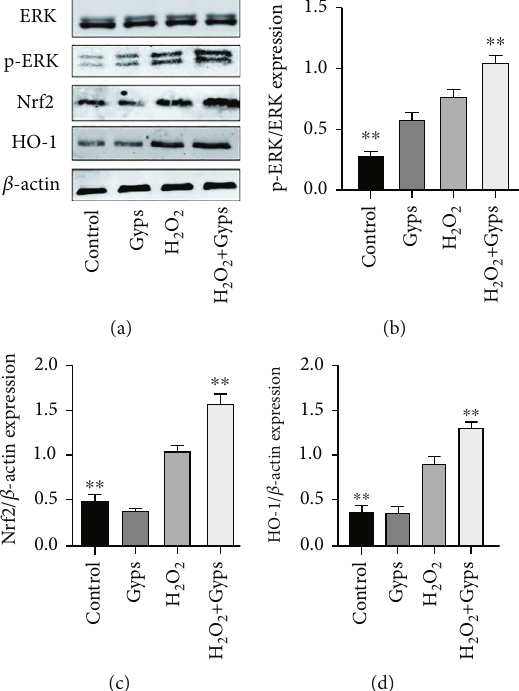
Figure 12: Gypenoside has a protective e ff ect on H O -induced oxidative stress through the ERK/Nrf2/HO-1 signaling pathway. The results 2 2 showed that compared with the blank control group, the expression of p-ERK, Nrf2, and HO-1 increased after H Compared with the H O group, the expression of p-ERK, Nrf2, and HO-1 in preintervention of gypenosides was further increased. (b) 2 2 Each represents the value obtained by dividing the band density of the phosphorylated transcription factor by the same total band density of the transcription factor. On the other hand, (c) and (d) are expressed by the ratio of band density to β -actin band density. Three samples from each of the three GO donors were taken for the experiment. All detections are repeated 3 times, with 3 replicate wells each time ( ∗ as P < 0 : 05 and ∗∗ as P < 0 : 01 ; P < 0 : 05 means the di ff erence is statistically signi fi cant, and P value is analyzed by one- way